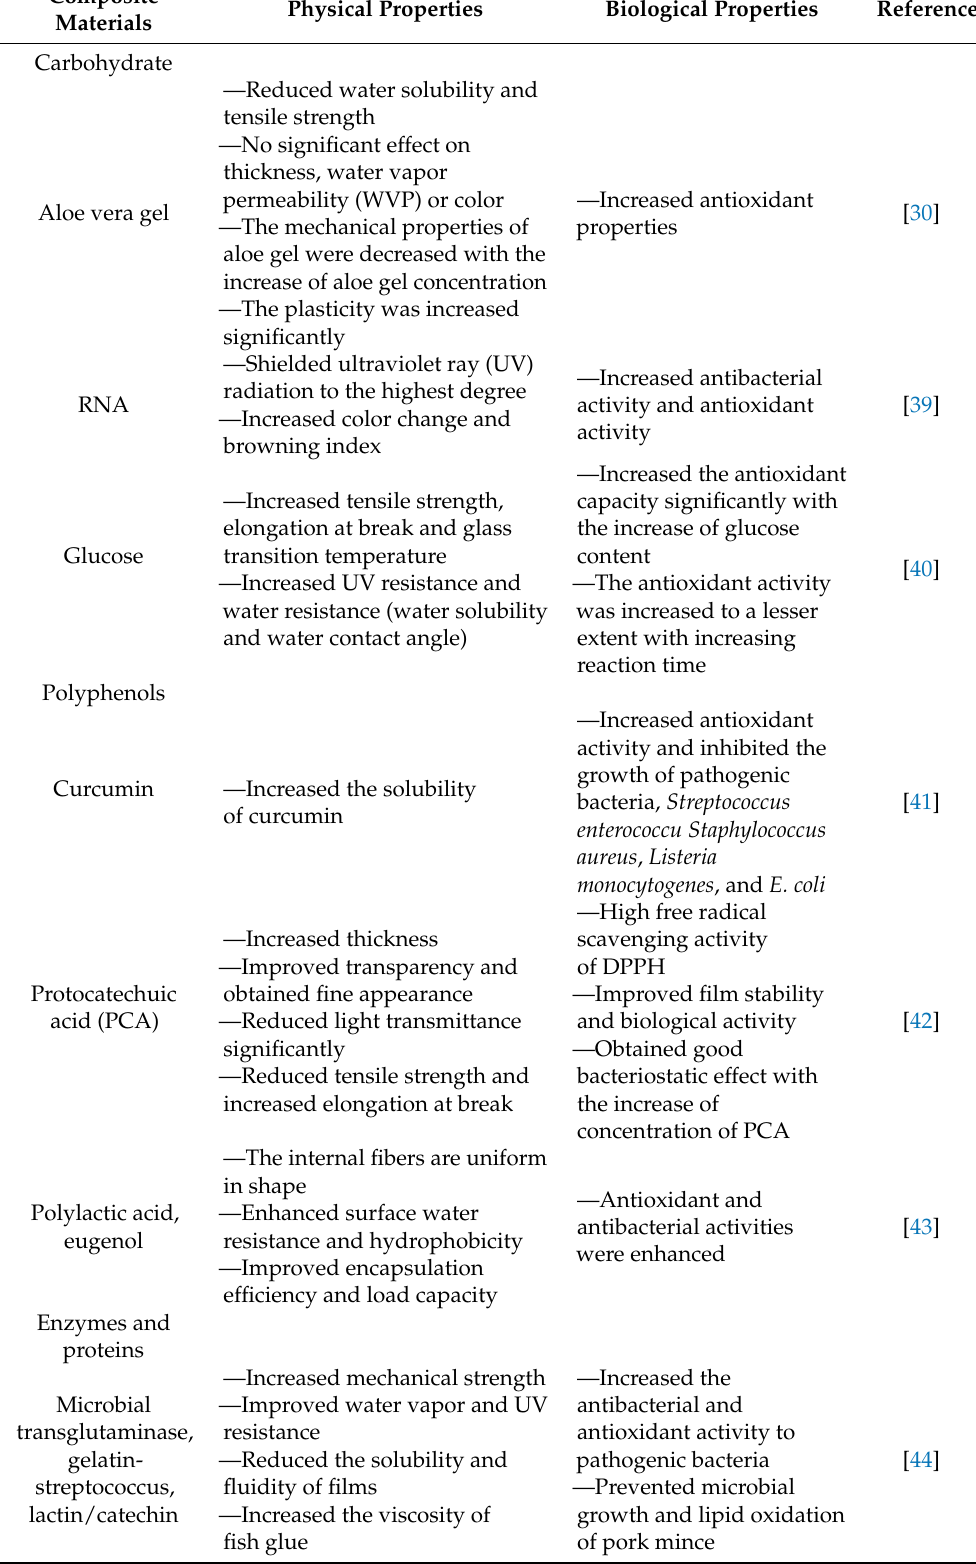
Table 1. Properties of gelatin-based composite edible